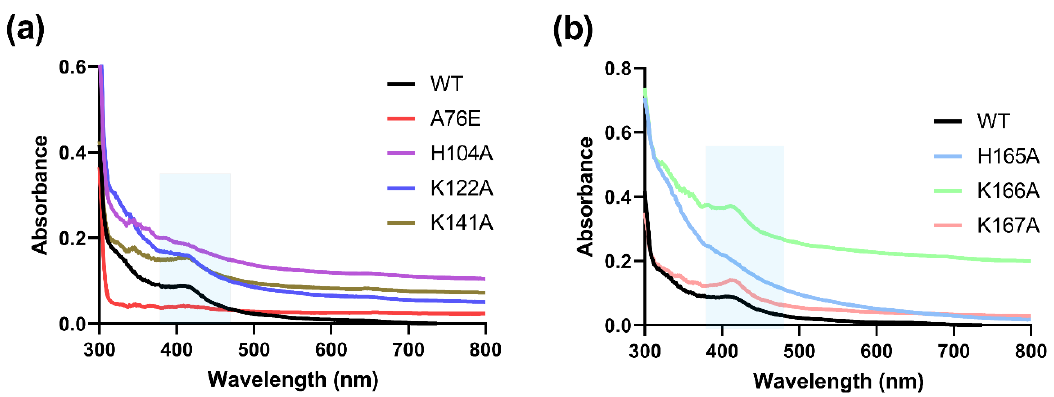
Figure 4. Multiple sequence alignment of Sox family of proteins. The secondary structures are displayed on the top of the alignment for HMG domain. Identical residues are shown in blue, whereas similar residues are shown in red. We have omitted initial N- terminal and the C-terminal alignment portion from the final figure.